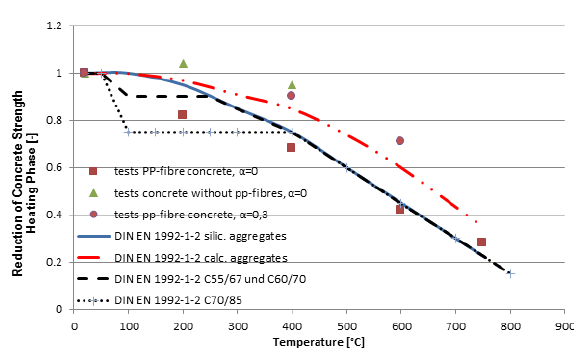
Figure 2. Comparison of reduction of compressive strength from the tests results with PP fibres with EN 1992-1-2 results for the specimen without PP fibres [9].